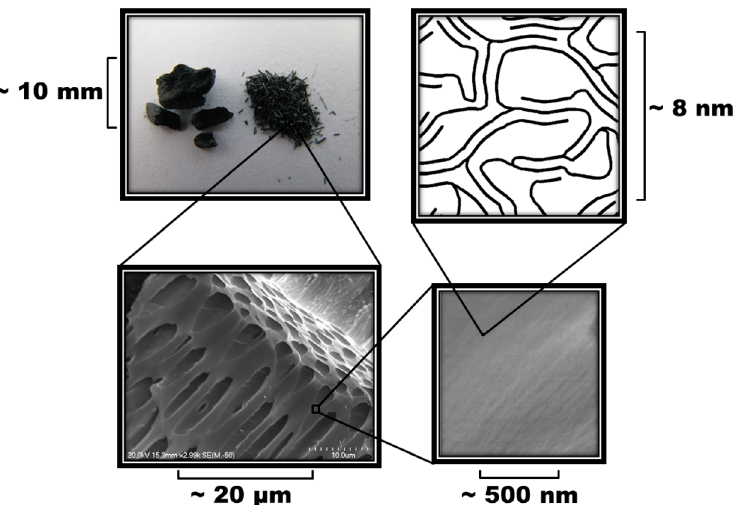
Figure 1. Features of biomass chars at various length scales [20]. Top left are structures which can be seen with the eye and easily photographed. The bottom two images are microscopic features which can be observed with scanning electron microscopes. The top-right sketch represents the nanostructure of well-carbonised chars where most of the carbon is part of interconnected graphene- like layers forming disordered stacks and nanometre-scale porosity.